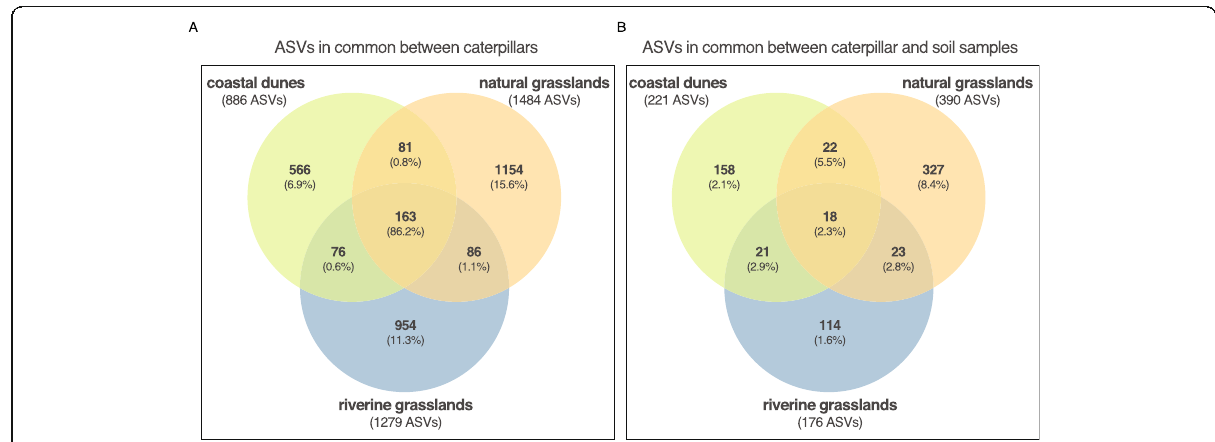
Fig. 2 Venn diagrams illustrating overlap of ASVs across the three habitats. Caterpillars in the three habitats shared 163 ASVs of the total 3080 ASVs ( a ). Caterpillar and soil samples shared 683 ASVs within the same habitat which represents 25.6% of the caterpillar microbiome, and 18 ASVs were found in both caterpillars and soils across the three habitats representing 2.3% of their mean relative abundance ( b ). Numbers inside the circles in bold represent the number of ASVs in each particular habitat; numbers below, in between brackets, represent the mean relative abundance of those ASVs within the respective